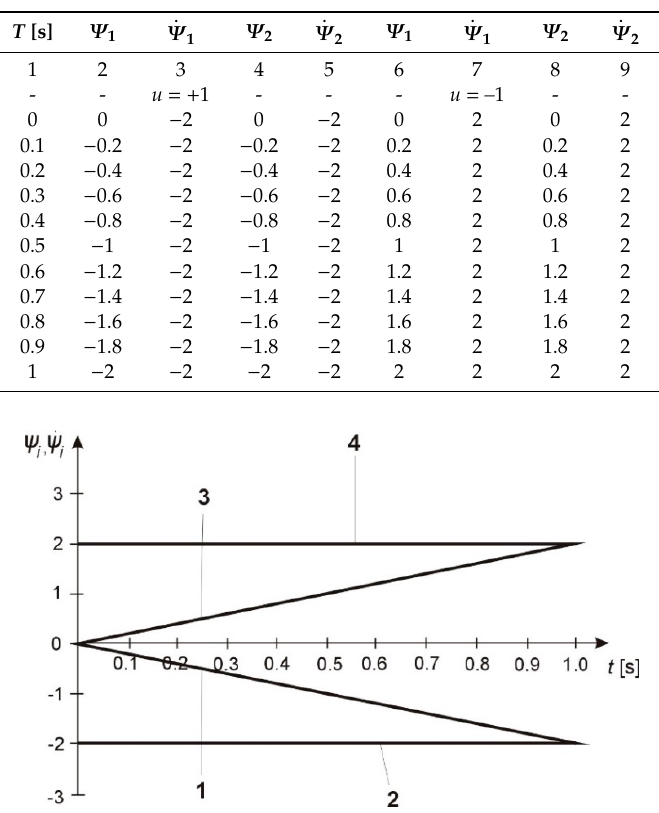
Table 2. Values of auxiliary functions.